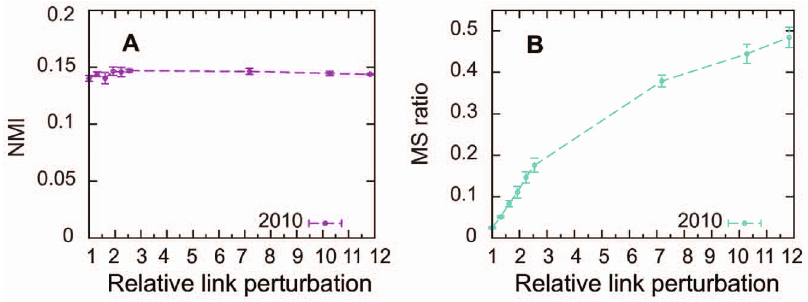
Figure 6. Completing triangles in the court case network generates non-destroyed resample networks. Panel A: Normalized mutual information (NMI) between the original network and the link-added networks as a function of the relative link perturbation. Panel B: Module size ratio between the original network and the link-added networks as a function of the relative link perturbation. Each point corresponds to an average over 100 runs.